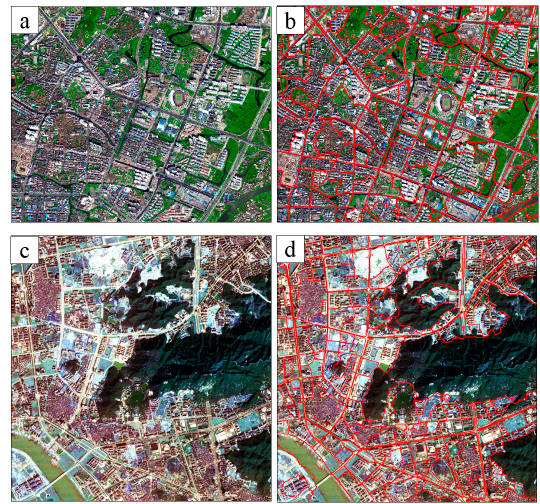
Figure 19. Geoscene segmentation results of the two study areas: ( a , c ) the original QuickBird images of Putian and Zhuhai and ( b , d ) their segmentation results.